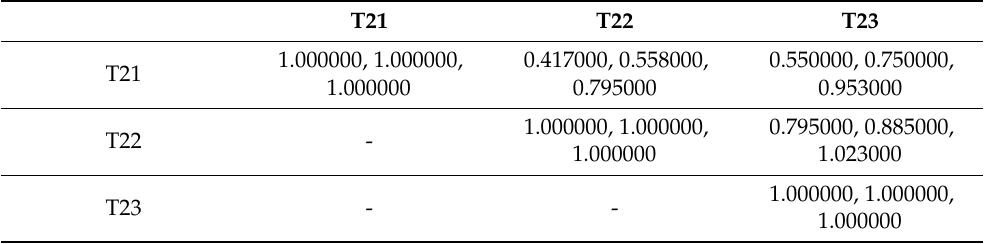
Table 3. Fuzzy aggregated pair-wise comparison matrix at level 2 for CIA Compromise.